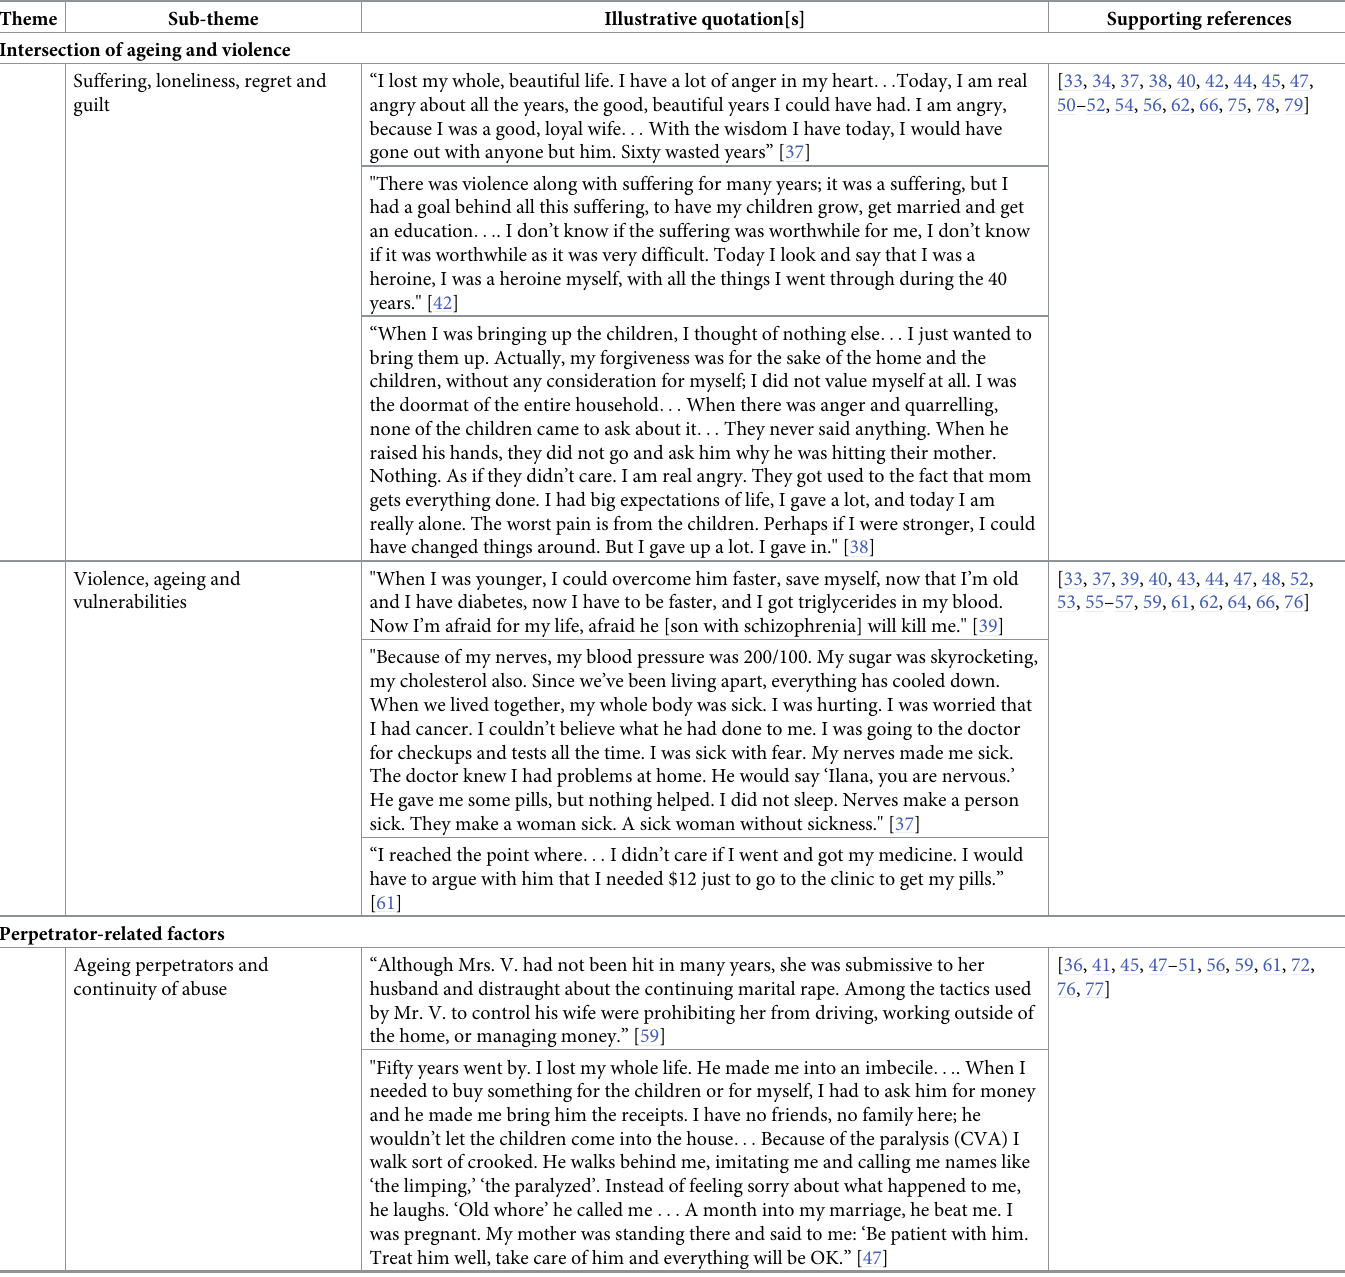
Table 3. Themes, sub-themes and